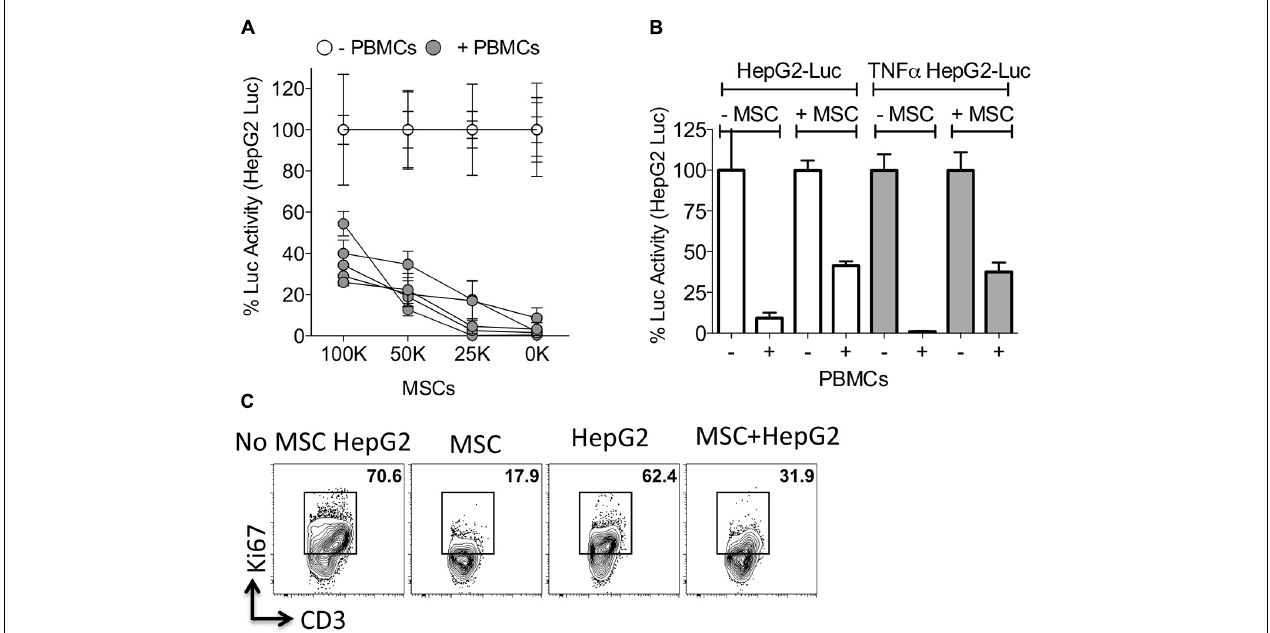
FIGURE 4 | Mesenchymal stromal cells protect HepG2 cells from lysis. (A) HepG2-Luc cells and increasing doses of MSCs were cultured together with or without SEB activated PBMCs from independent donors. Three days later luciferase was measured to detect the survival of HepG2-Luc cells. Percentage luciferase activity was calculated based on the readouts of HepG2-Luc cells with appropriate doses of MSCs and without PBMCs. Mean and standard deviation are shown from technical replicates. (A) Represents cumulative data derived from five independent PBMC and MSC donors. (B) ± TNF α primed HepG2-Luc cells were co-cultured with or without MSCs and/or SEB activated PBMCs. Three days later luciferase was measured to detect the survival of HepG2-Luc cells. Mean and standard deviation are shown from technical replicates. Representative results are shown from three independent experiments. (C) MSCs and HepG2 cells were cultured together with SEB activated PBMCs. Four days later T-cell proliferation was measured by Ki67 intracellular staining and FACS plots are shown. Representative results are shown from two independent